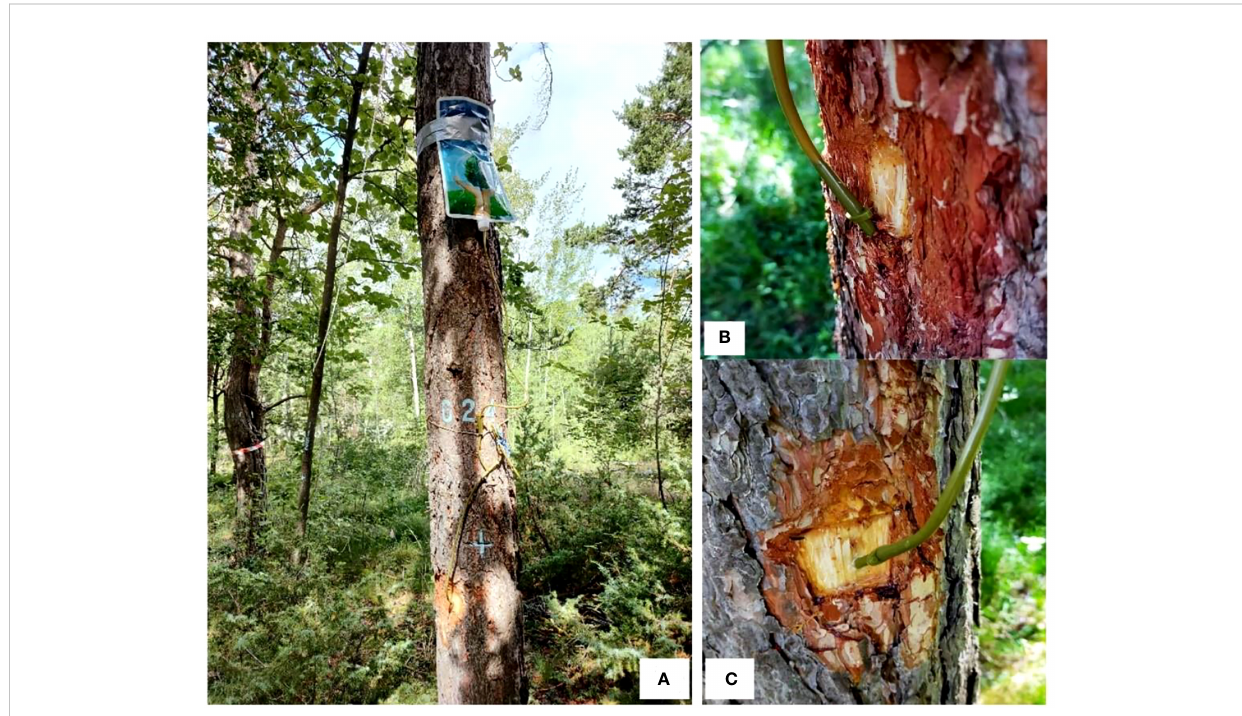
FIGURE 3 Glucose infusion experiment with adult Scots pine (Pinus sylvestris) trees (A) , for phloem infusion (B) and xylem infusion (C) in Pfynwald, Valais, Switzerland. For phloem infusion (B) , a hole (~20 mm in depth, and 3.5 mm in diameter) between the bark and xylem, parallel to the stem surface,